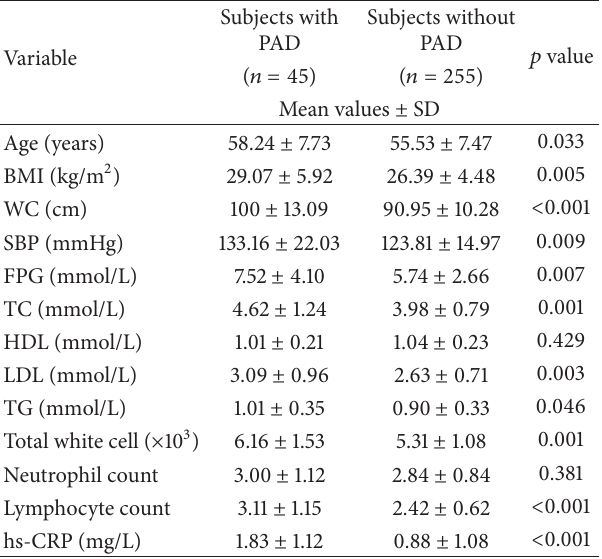
Table 2: Association of traditional and nontraditional risk factors and peripheral arterial